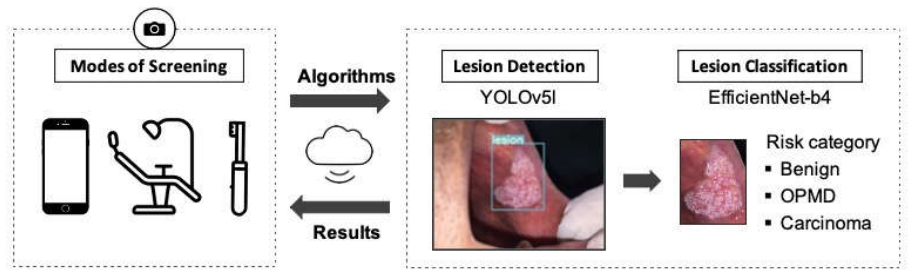
Figure 7. Proposed two-stage pipeline for oral cancer screening. It includes the detection of oral lesions from photographic images in the first stage and the classification of the detection region in the second stage using deep learning algorithms. YOLOv5l and EfficientNet-b4 models were selected for the pipeline as they achieved overall good performance in terms of both accuracy and inference